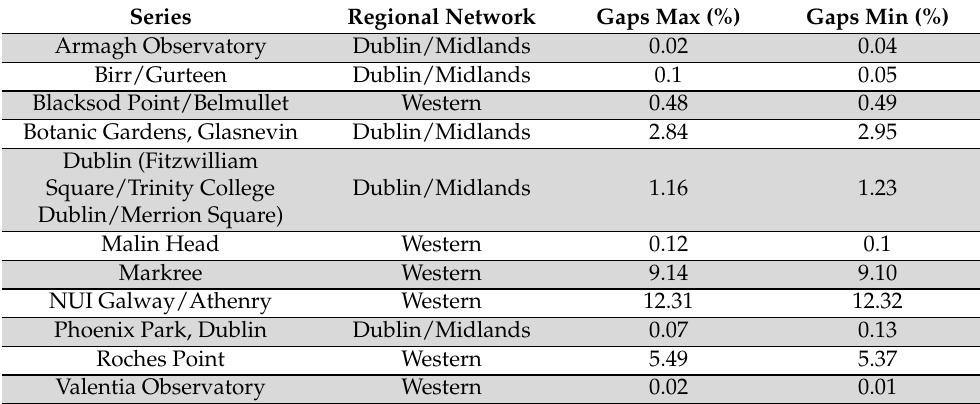
Table 4. Long-term MAX and MIN series tested for homogenisation. All series are part of the national network. Series are included in regional networks: Dublin/Midlands and